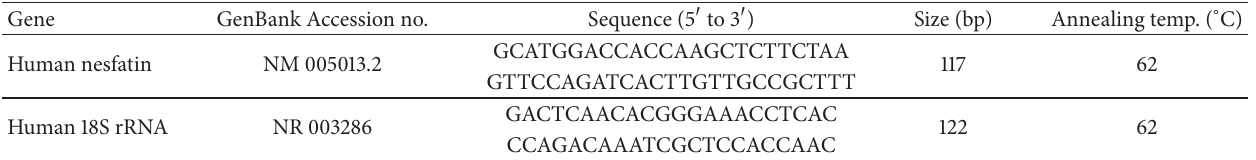
Table 2: Primers for targeted